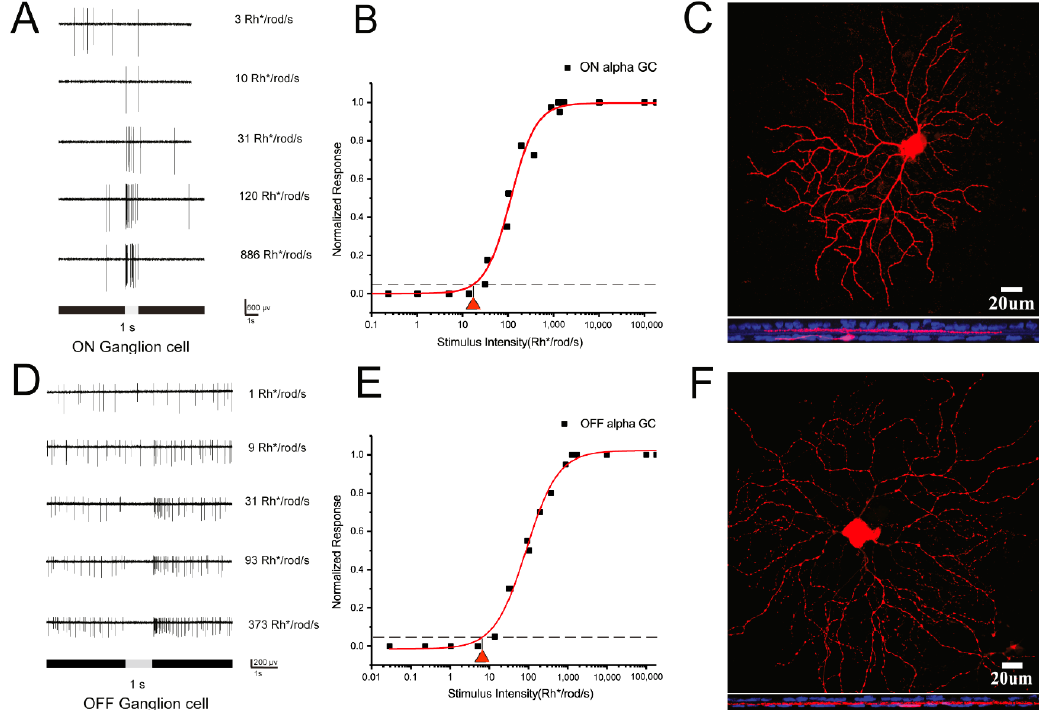
Figure 1. Dark-adapted ON and OFF α -RGCs show low-intermediate light threshold sensitivities. A and D ; ON and OFF RGCs show increasing spikes to full-field 525 nm light stimuli of increasing intensities. B and E ; Intensity–response function of the ON and OFF α -RGC, showing a threshold sensitivity of around 10 Rh* /rod/s. C and F ; ON and OFF α -RGCs can be visualized by Neurobiotin injection after recording. Double labeled with anti-ChAT antibody (blue). Scale bar = 20 µm.